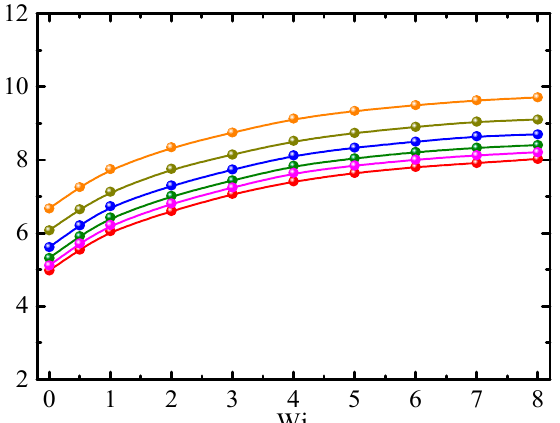
Figure 10. Nusselt number vs. Weissenberg number for different Reynolds numbers ( β 0 = 0.2, Φ = 1.0%, α = 0.2). — • —: Re = 0.5; — • —: Re = 1; — • —: Re = 2.5; — • —: Re = 10; — • —: Re = 100; and — • —: Re = 500.